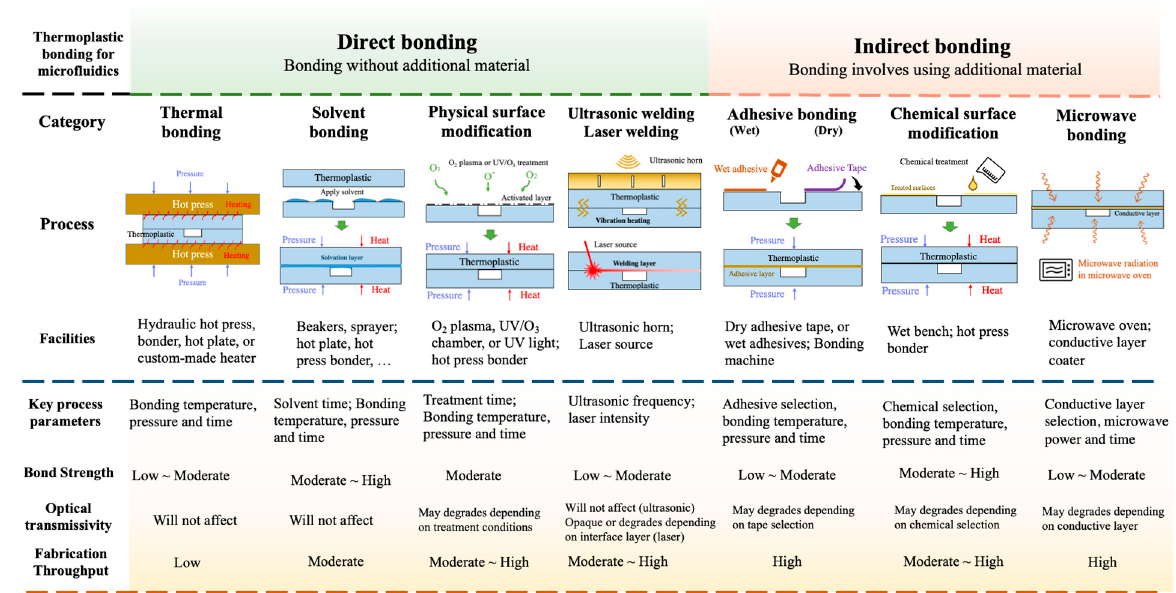
Figure 8. Summarization of direct and indirect bonding methods for thermoplastic microfluidics.